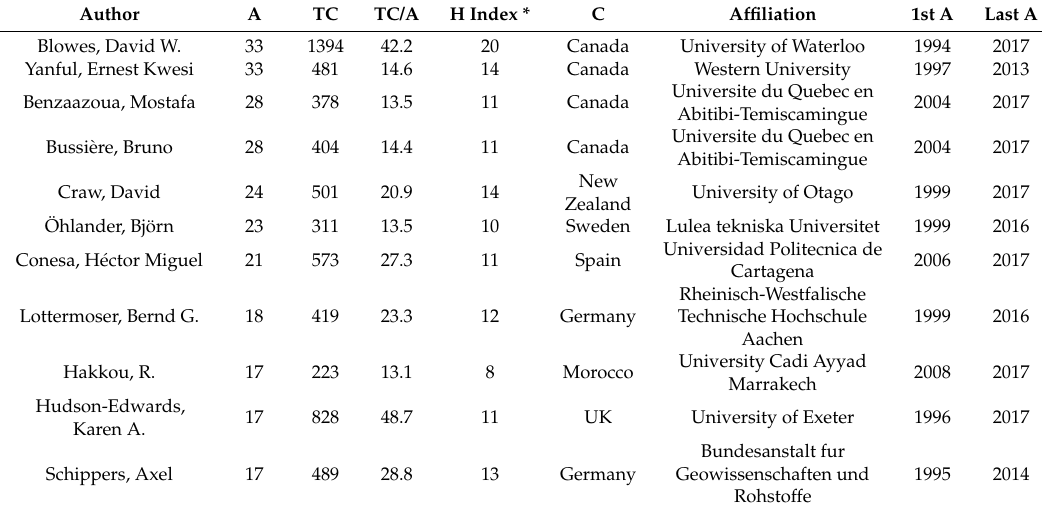
Table 6. Most productive authors in MW